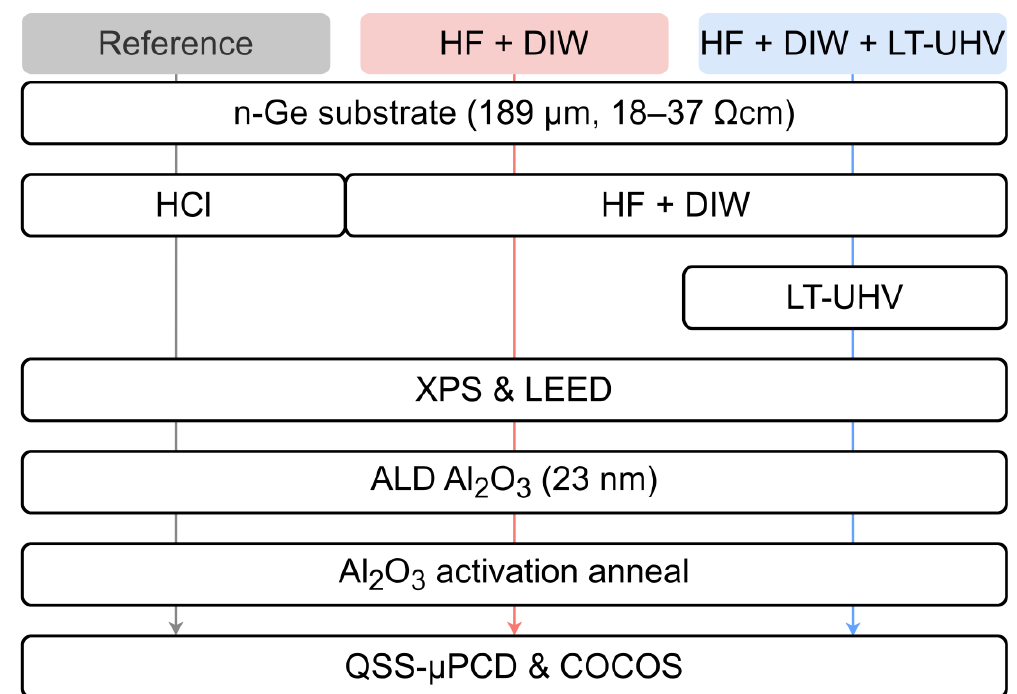
Figure 1. The process flow of the conducted experiments.